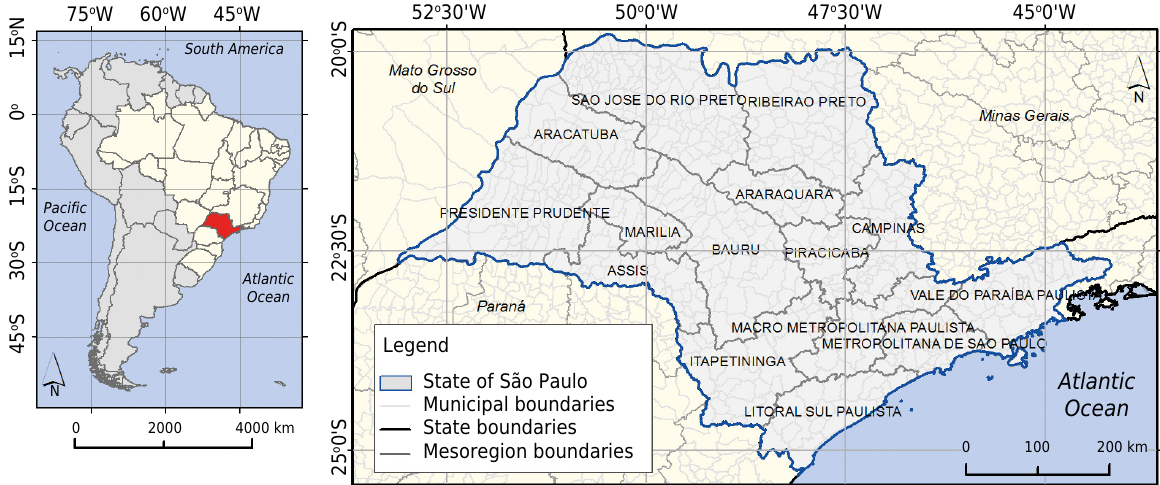
Figure 1. Localization of study area, state of São Paulo